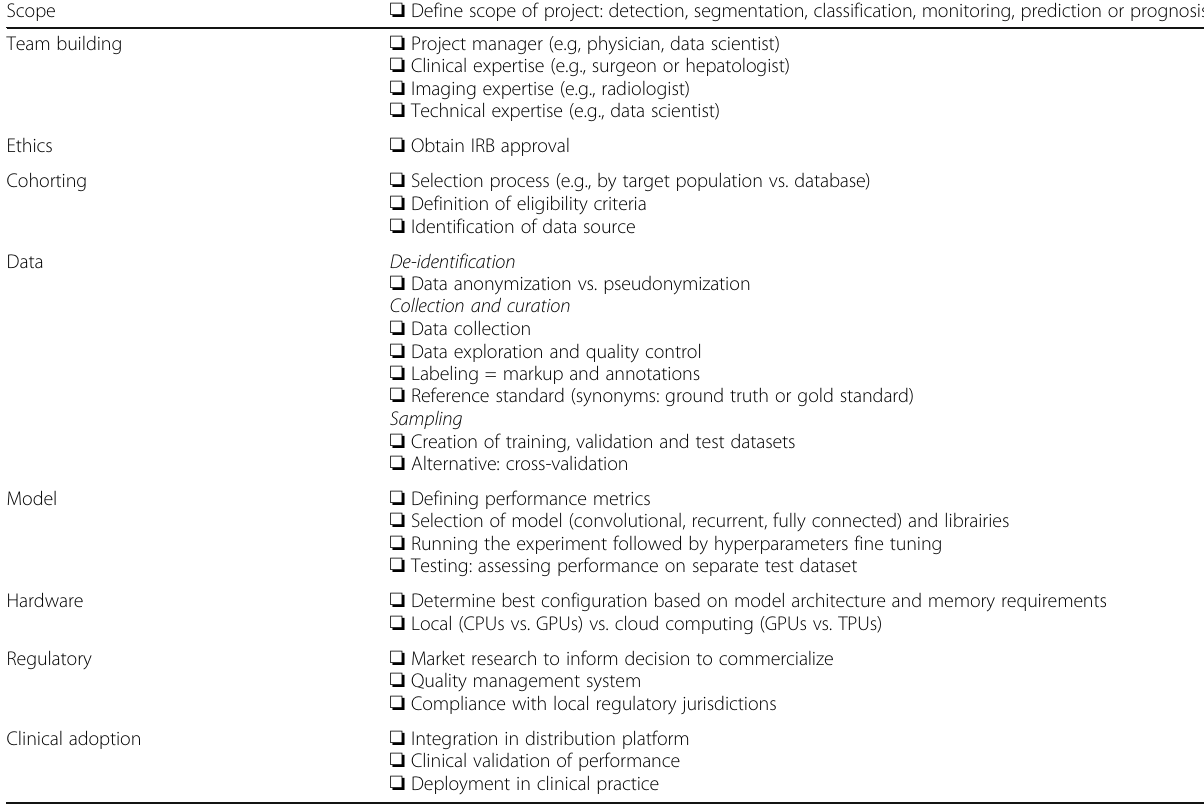
Table 1 Checklist of steps required for management of project involving deep learning Scope ❏ Define scope of project: detection, segmentation, classification, monitoring, prediction or prognosis. Team